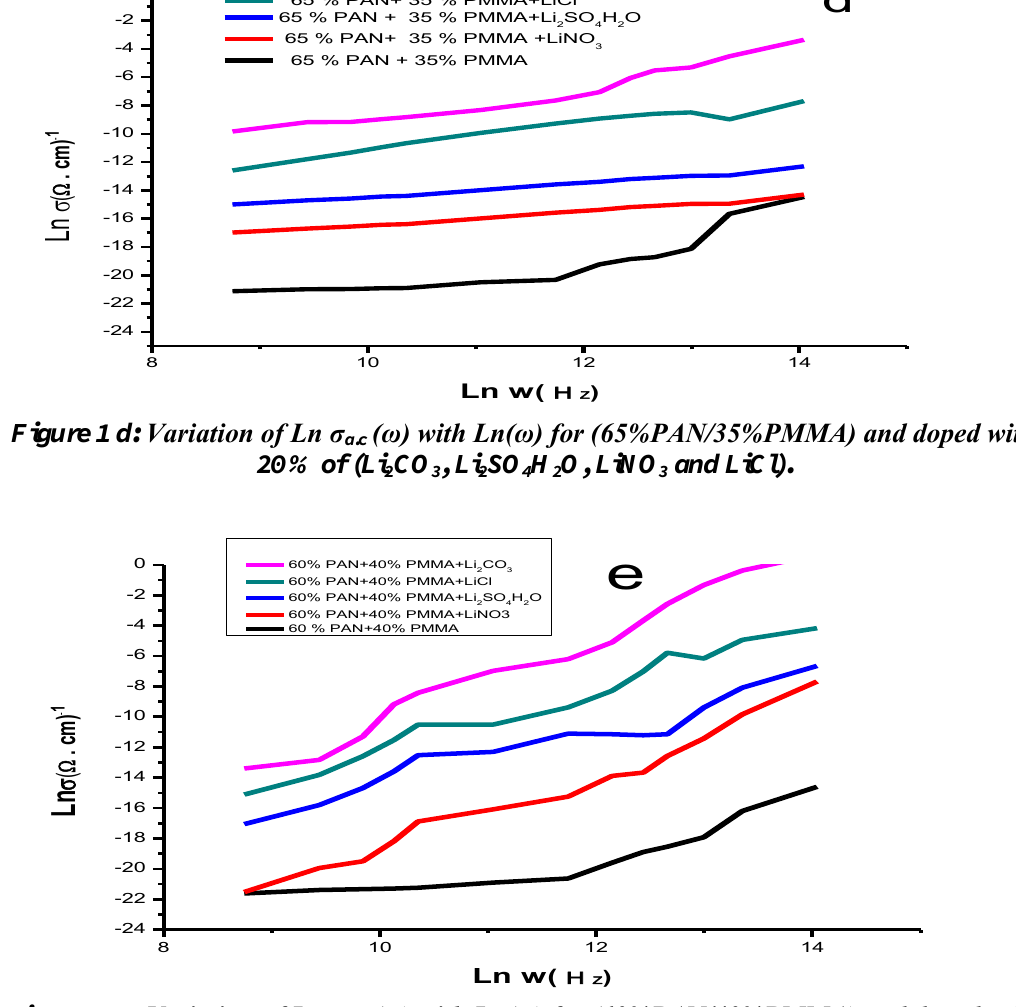
(ω) with Ln(ω) for (62%PAN/42%PMMA) and doped with a.c CO , Li SO H O, LiNO and 2 3 2 4 2 3